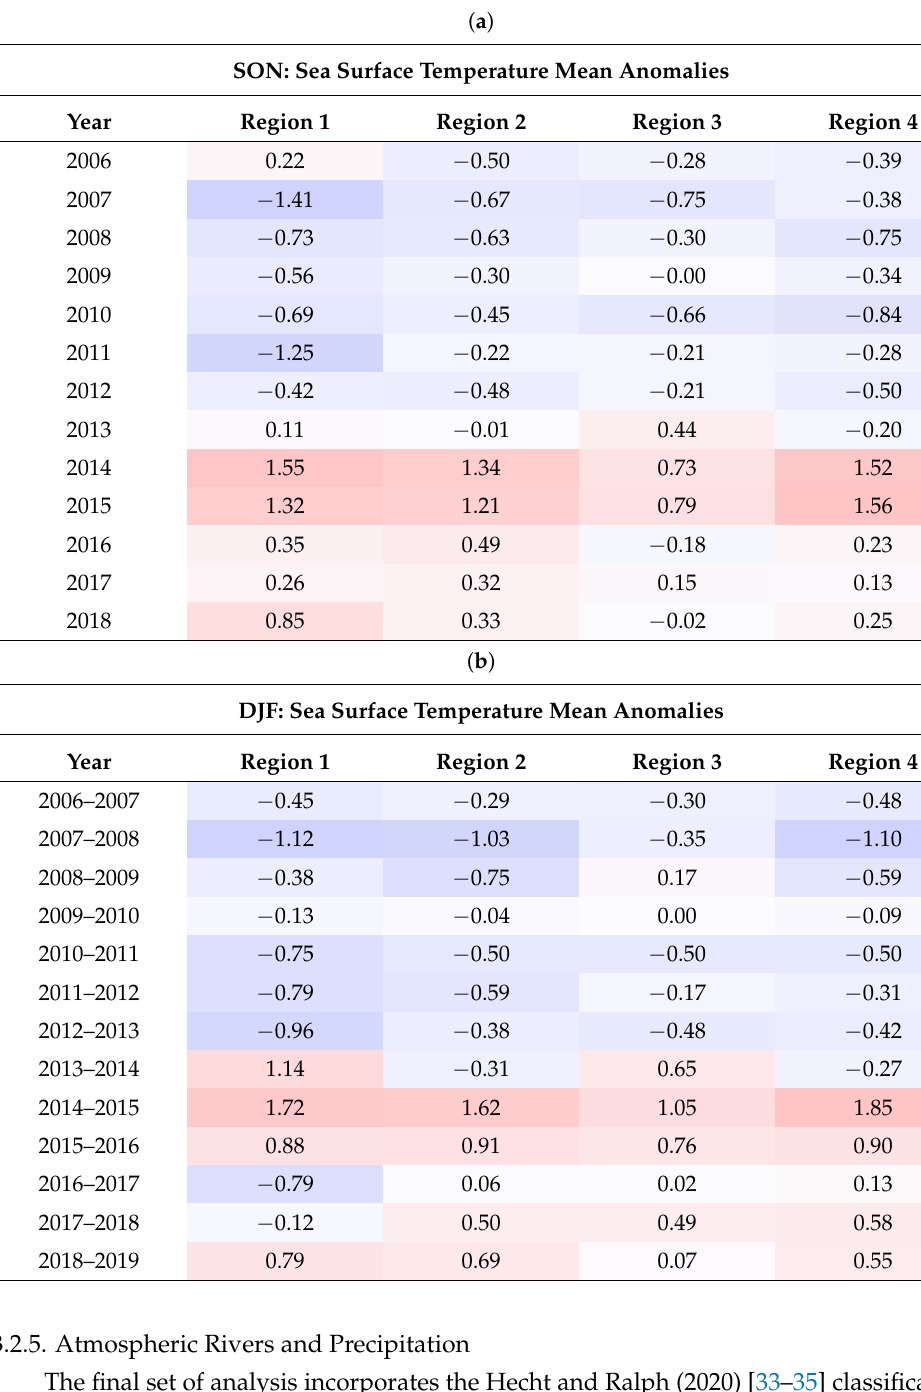
Table 4. Sea surface temperature anomalies ( ◦ C) from 2006–2019 for ( a ) SON and ( b ) DJF. Color range in table reflects each region seasonal mean as seen in Figure